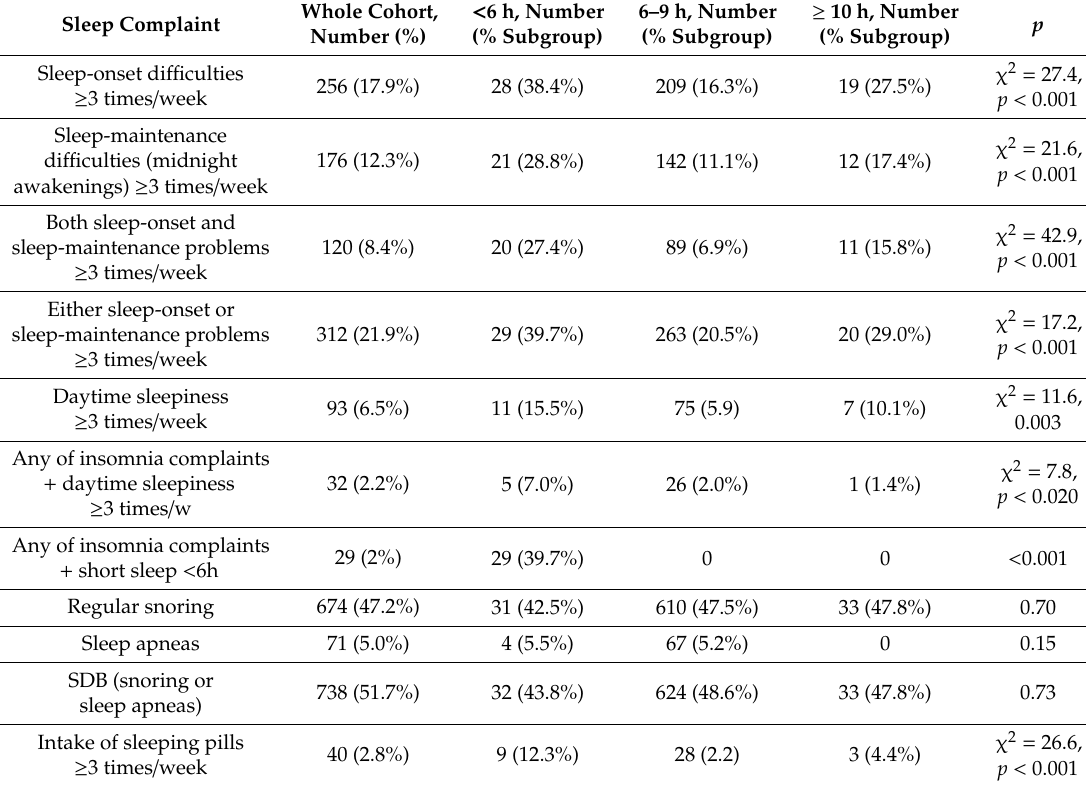
Table 1. Sleep-related complaints in the cohort. SDB: sleep-disordered breathing.